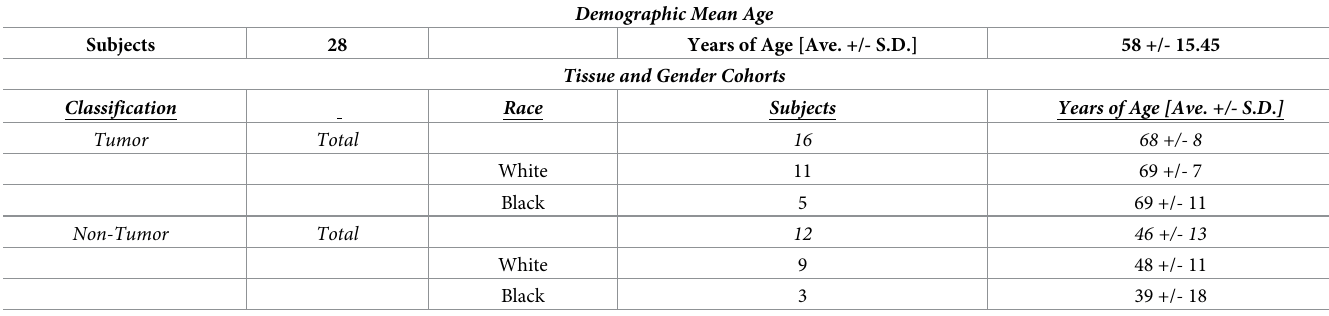
Table 1. Demographic information of the pancreatic tissue